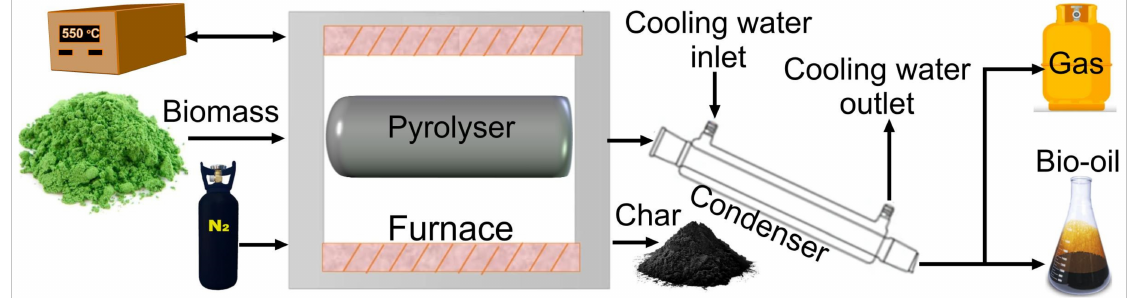
Figure 2. Experimental setup for the study of